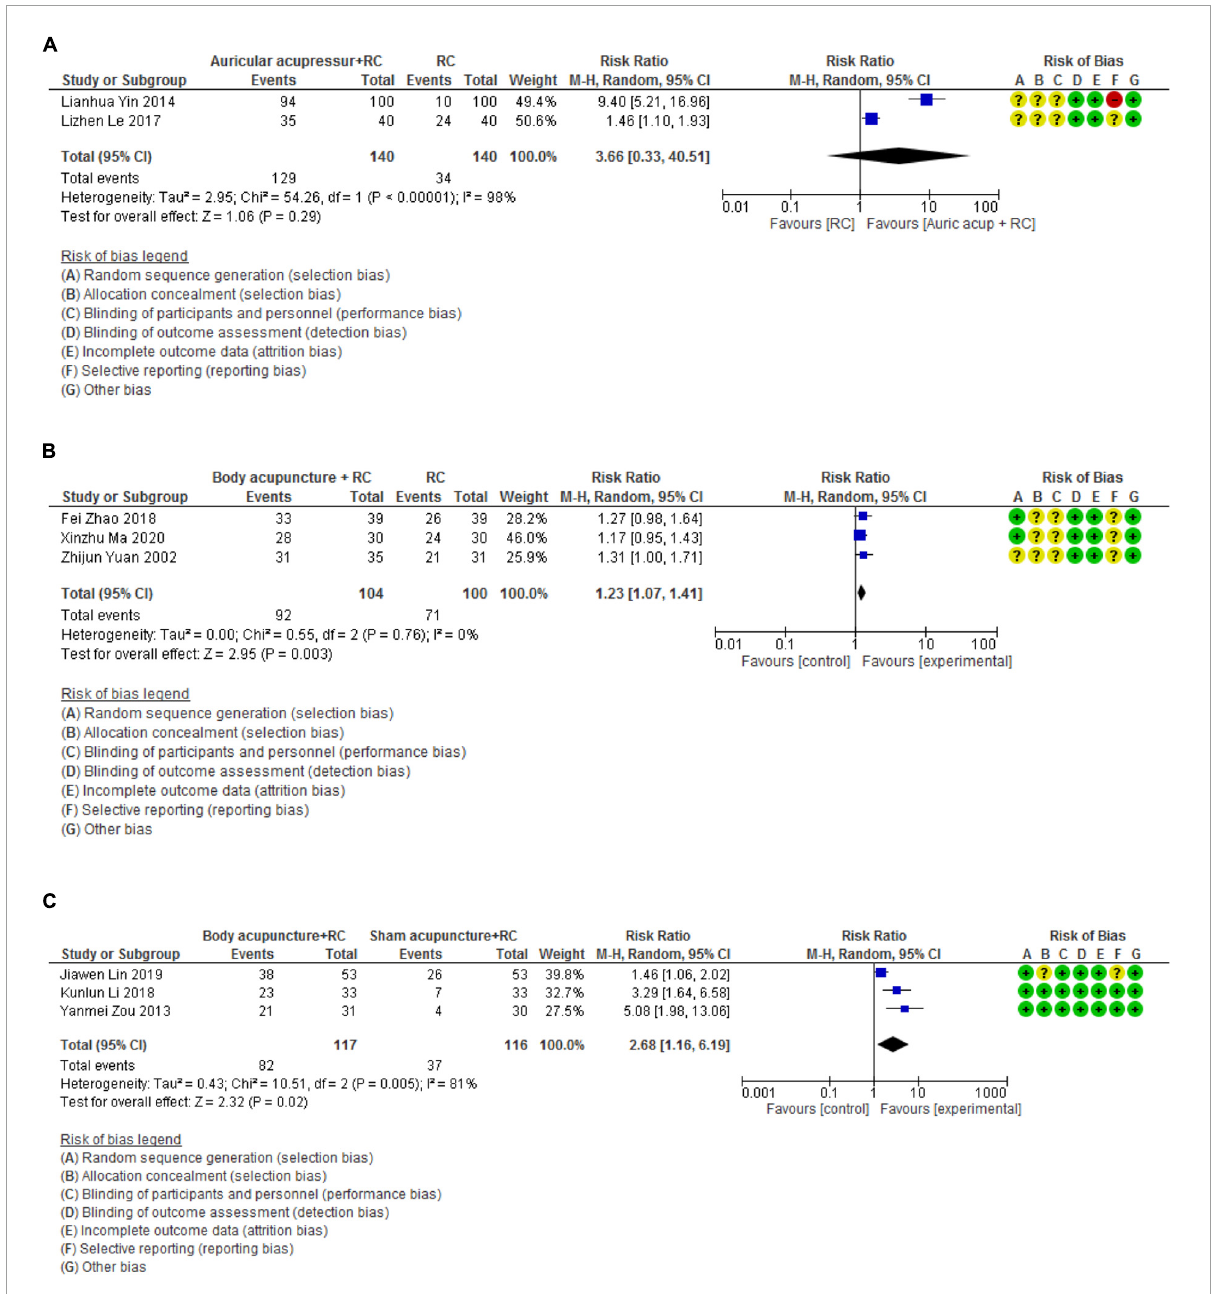
FIGURE2 Forest plots of effective rate measured by 24-h Holter. (A) Forest plot_Auricular acupressure + RC vs. RC. (B) Forest plot_Body acupuncture + RC vs. RC. (C) Forest plot_Body acupuncture + RC vs. Sham acupuncture + RC. RC, routine care.